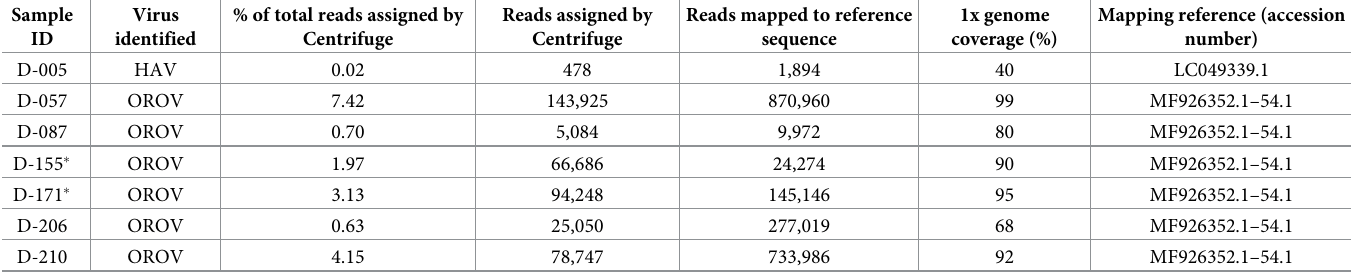
Table 1. Viruses identified from 23 patient plasma samples by metagenomic sequencing, 17 of which were negative for all pathogens tested for by RT-PCR, includ- ing one sample (D-087) in which OROV was initially detecting by metagenomic sequencing. The remaining five samples (D-057, D-155, D-171, D-206 and D-210) were initially shown to be positive for OROV using the qRT-PCR assay described in this study. The cut-off value used was � 40% genome coverage (from mapping reads to reference genome). Sample Virus ID